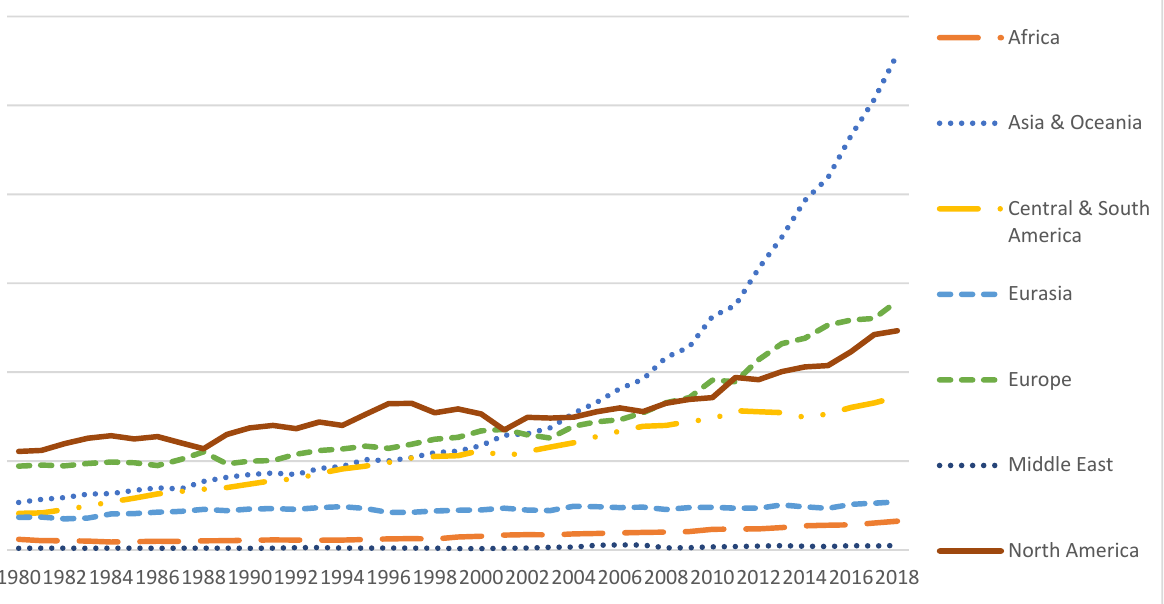
Figure 1. Total renewable electricity net generation. Source: Energy Information Administration (EIA) [1].